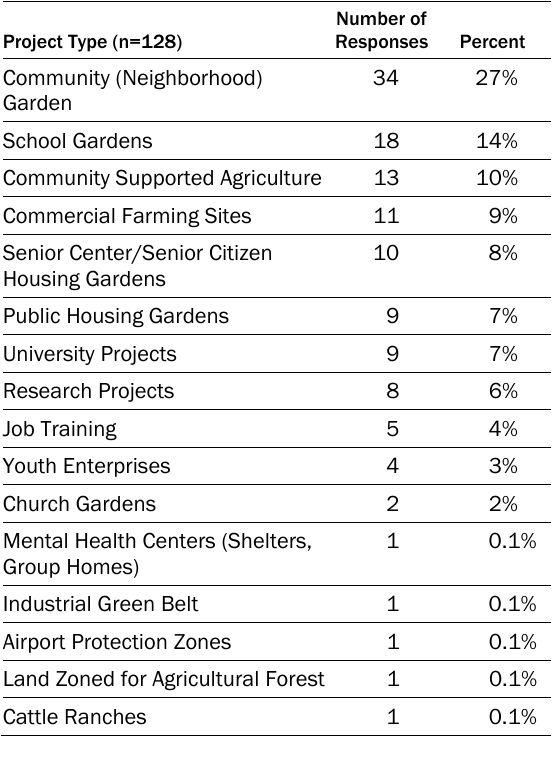
Table 2. Urban Agriculture Project Types